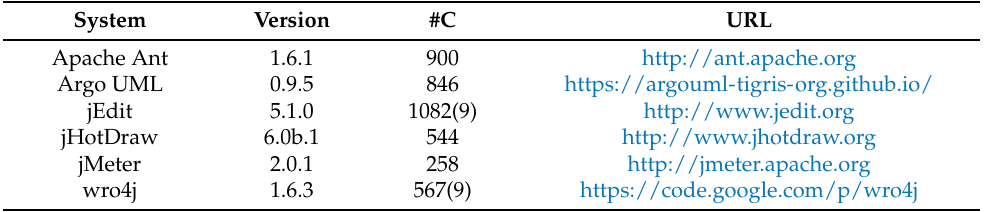
Table 5. Basic information of the subject software